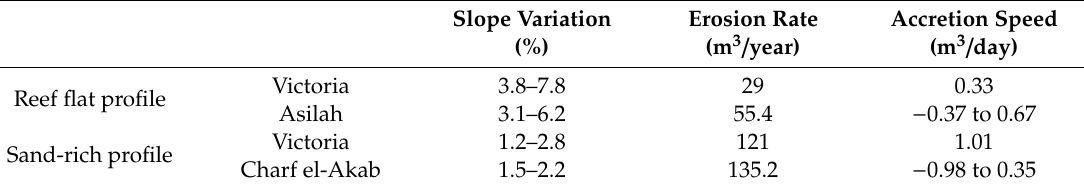
Table 2. Comparison of erosion and accretion volume rates between reef flat and sand-rich profiles. The beaches are Victoria (Cadiz, Spain), Asilah and Charf el-Akab (Morocco).